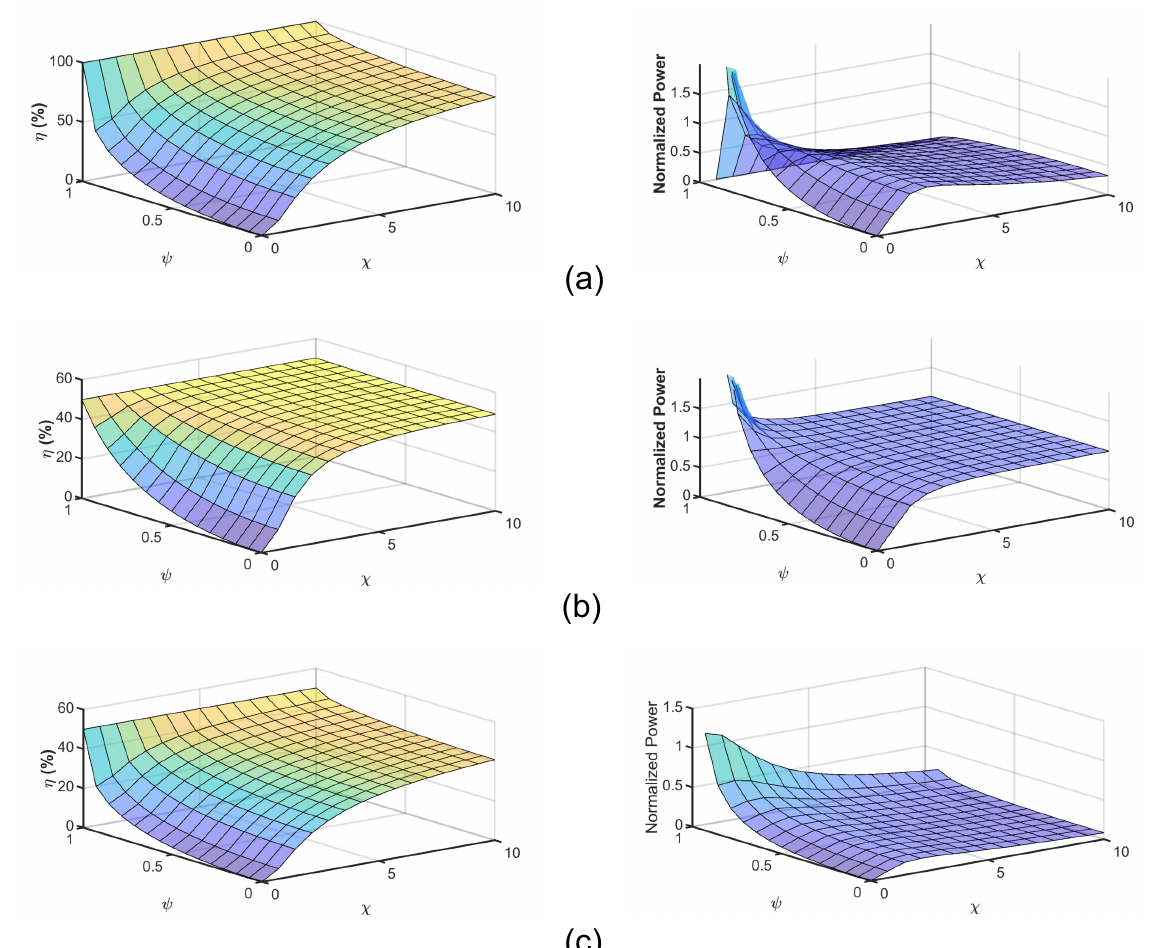
Figure 3. The efficiency of CPT system: ( a ) Maximum efficiency solution. ( b ) Maximum power solution. ( c ) Conjugate- image solution.